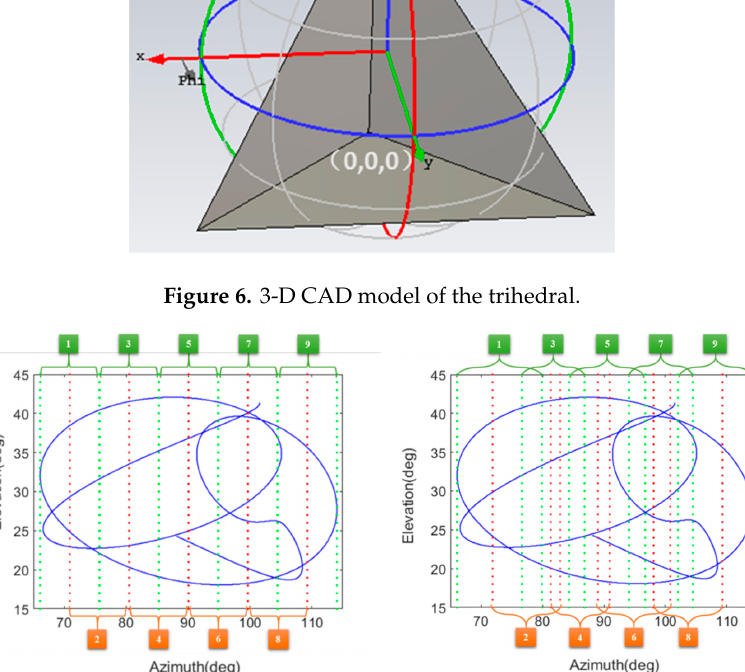
Figure 6. 3-D CAD model of the trihedral.